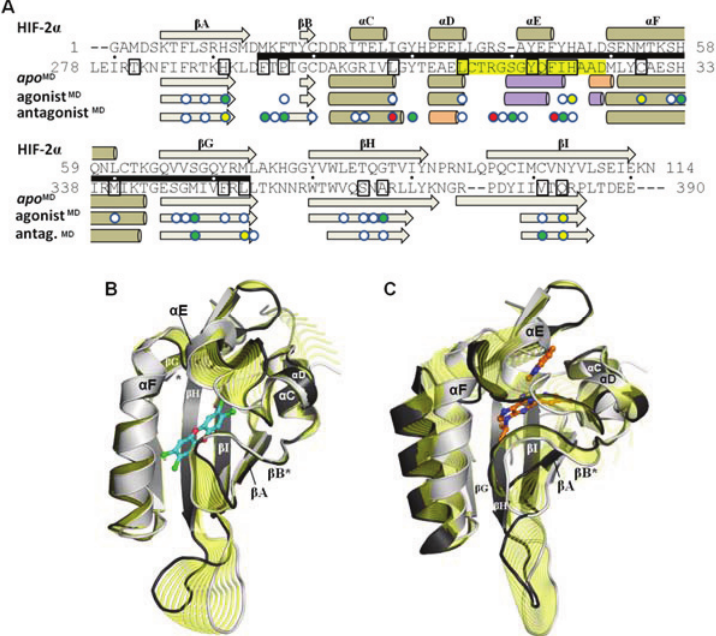
Figure 8. Influence of agonist and antagonist binding on AHR PAS-B structure. ( A ) A structure-based sequence alignment is shown between HIF-2(cid:2) and the equilibrated AHR molecular dynamics models. The standard secondary structure elements of PAS-B domains are indicated for HIF-2(cid:2) and the AHR models, with grey arrows depicting (cid:5)-strands, tan cylinders as (cid:2)-helices, pink as 3 10 -helices, and purple as pi-helices. Every ten residues are denoted with (.) for the sequence of AHR and residues which have been shown through mutagenesis to be important for agonist binding are noted in black boxes [13,18]. The region of the murine AHR PAS-B that was shown to interact with HSP90 is denoted with a black bar. Colored circles indicate residues contacted by the bound ligands at 50 ns of simulation time, with white indicating (cid:4)1 Å 2 buried, green for (cid:4)10 Å 2 buried, yellow for (cid:4)20 Å 2 buried, and red for (cid:4)30 Å 2 buried. ( B ) A morph between the apo MD (light grey) and agonist MD (dark grey, TCDD shown with blue carbons) conformations is shown, with yellow highlighting the structural differences between the apo and the bound state. The secondary structural elements are depicted. The (cid:5)B and (cid:5)G regions are noted with an asterisk (*) as they exhibit near (cid:5)-strand geometry. ( C ) A morph between the apo MD (light grey) and antagonist MD (dark grey, GNF351 shown with orange